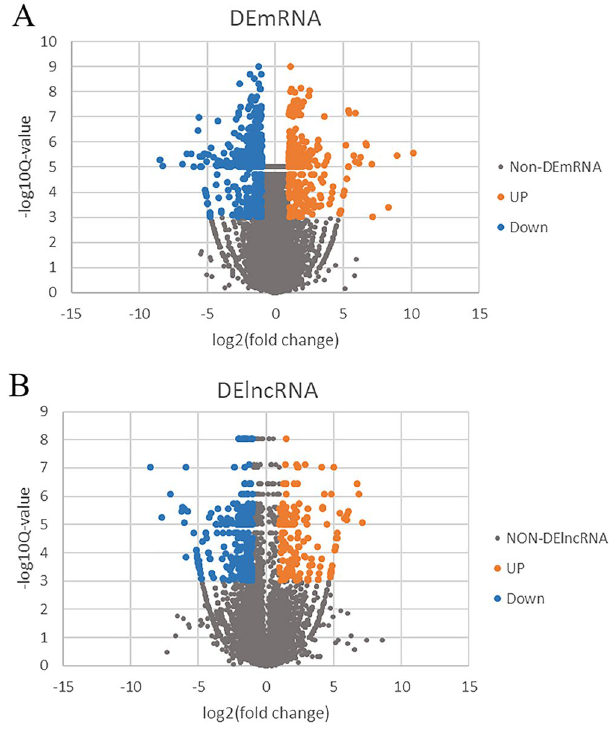
Figure 1. Different mRNAs expression amd different lncRNAs expression. ( A ) Volcano map of significantly different expression of mRNAs. Orange spots represent up-regulated mRNAs, and blue spots represent down- regulated mRNAs. ( B ) Volcano map of significantly different expression of lncRNAs. Orange spots represent up-regulated lncRNAs, and blue spots represent down-regulated